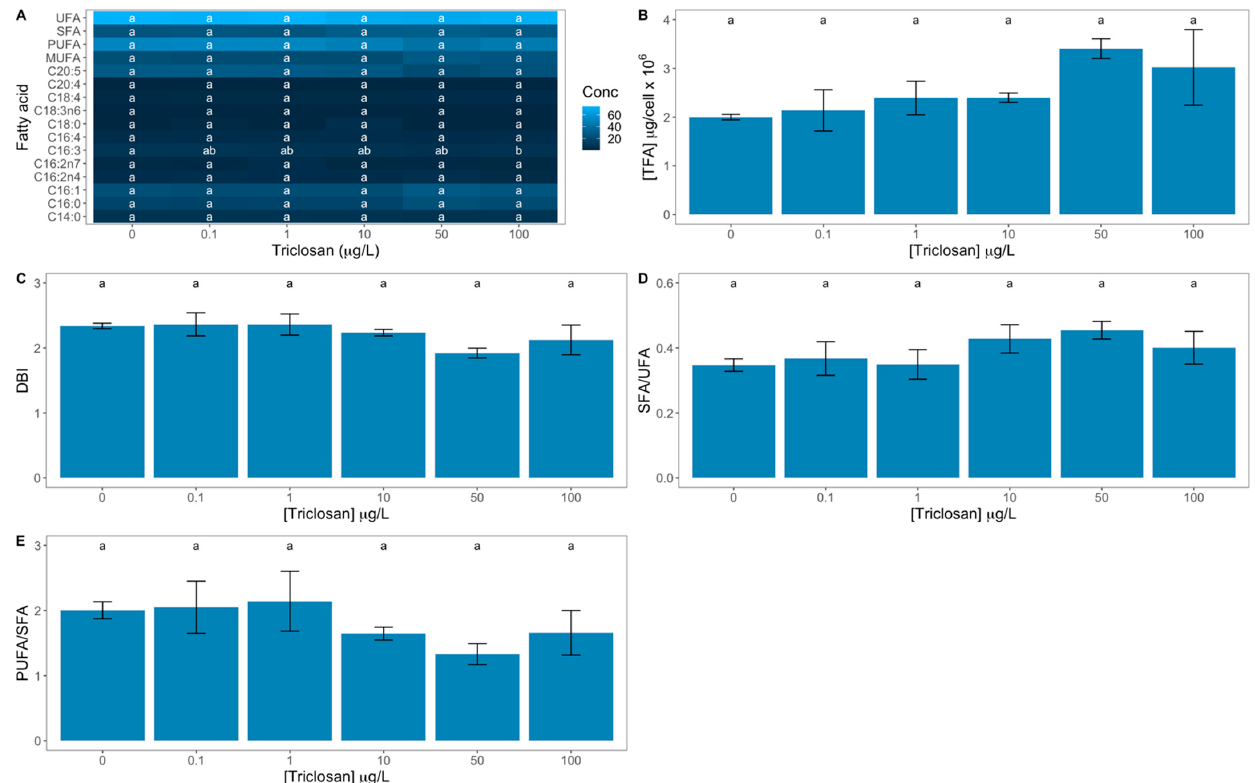
Figure 6. Triclosan-exposed Phaeodactylum tricornutum cultures fatty acid profiles and respective saturation classes relative concentrations [myristic acid (C14:0), palmitic acid (16:0), palmitoleic acid (16:1), hexadecadienoic acid (C16:2n4), palmitolenic acid (C16:2n7), palmitolinolenic acid (C16:3), palmiti- donic acid (C16:4), stearic acid (C18:0), γ -linolenic acid (C18:3), stearidonic acid (C18:4), arachidonic acid (C20:4), eicosapentaenoic acid (C20:5), monounsaturated (MUFA), Polyunsaturated (PUFA), saturated (SFA) and unsaturated (UFA) fatty acids, A ], total fatty acid content (TFA, B ), double-bound index (DBI, C ), saturated to unsaturated fatty acids ratio (SFA/UFA, D ), and polyunsaturated to saturated fatty acid ratio (PUFA/SFA, E ) (average ± standard error, n = 3; different letters